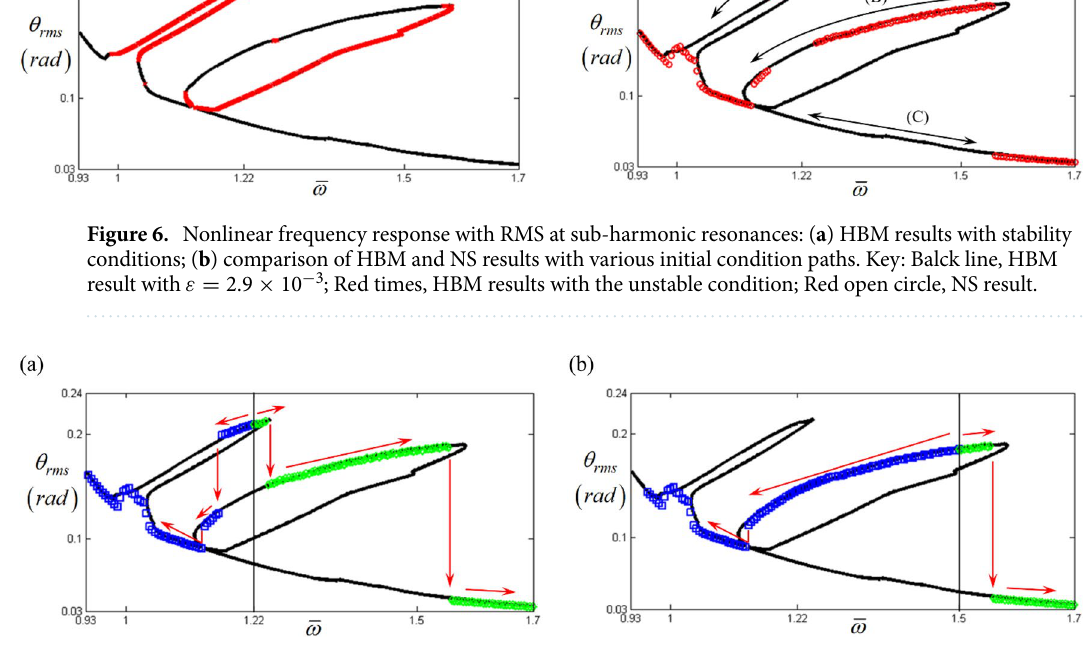
Figure 7. Comparison of HBM with NS under various initial conditions: ( a ) comparison of HBM with NS calculated at ̟ = 1.22 ; ( b ) comparison of HBM with NS calculated at ̟ = 1.5 . Key: Black line, HBM result with ε = 2.9 × 10 − 3 ; Blue square, NS results with frequency down-sweeping; Green diamond, NS results with frequency